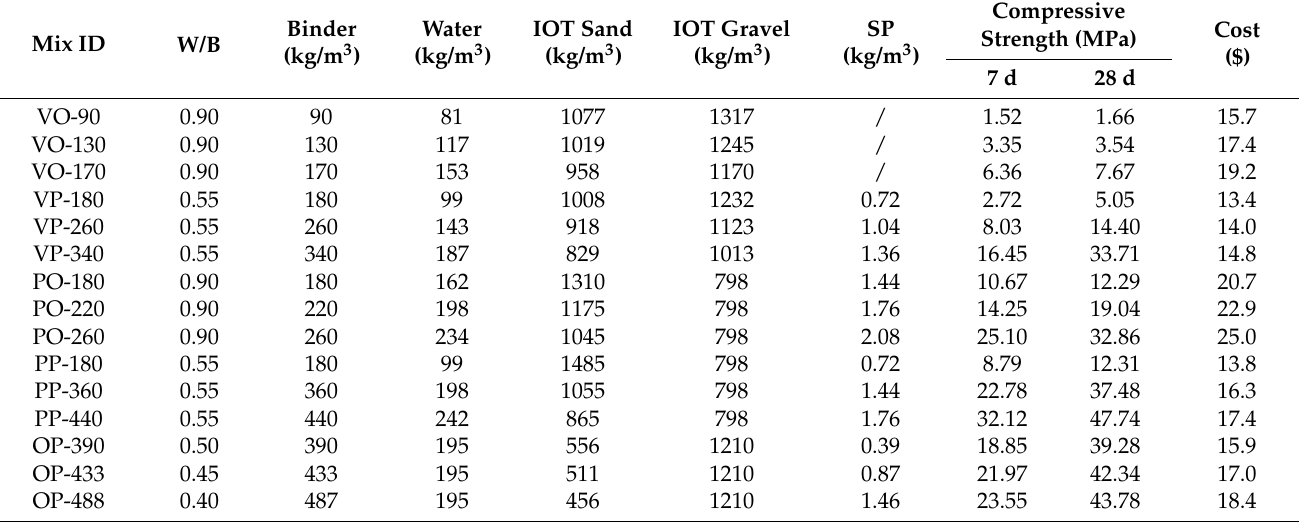
Table 3. Compressive strength and cost of the artificial